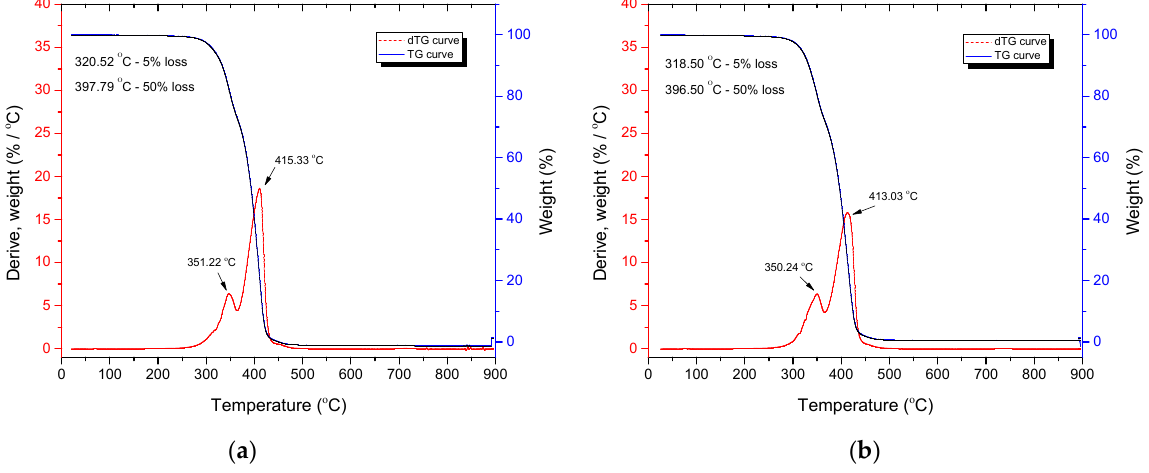
Figure 4. TG and DTG curves of ( a ) PCL/PLA/CF 70/30/0 and ( b ) PCL/PLA/CF 70/30/3.0 blends.